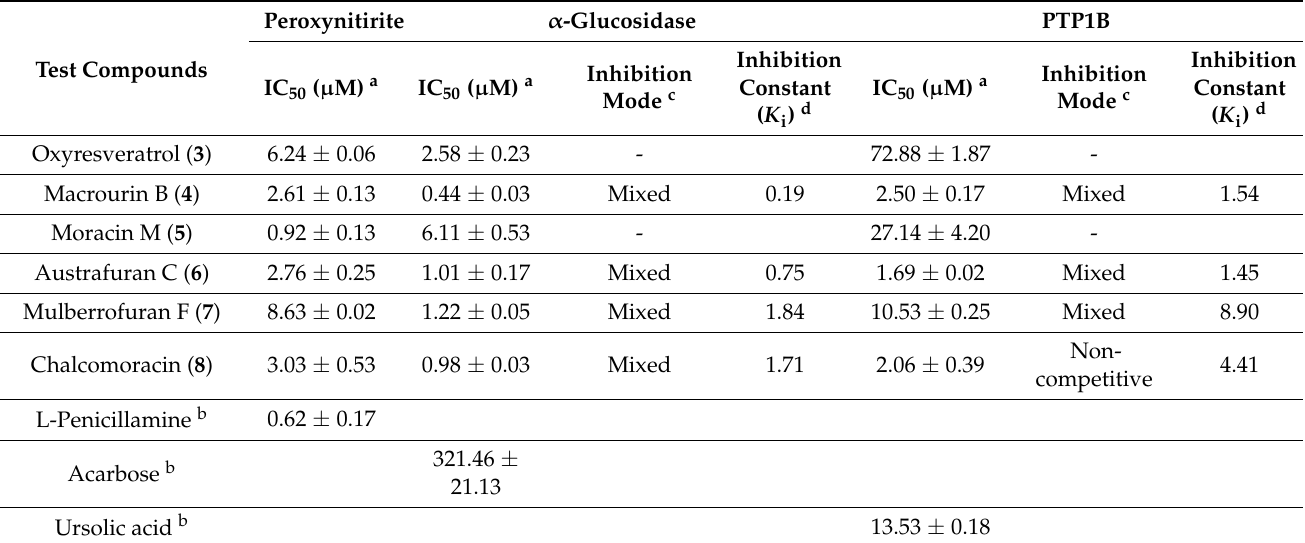
Table 3. Inhibitory activities of isolated compounds from Morus bombycis leaves against α -glucosidase and PTP1B.